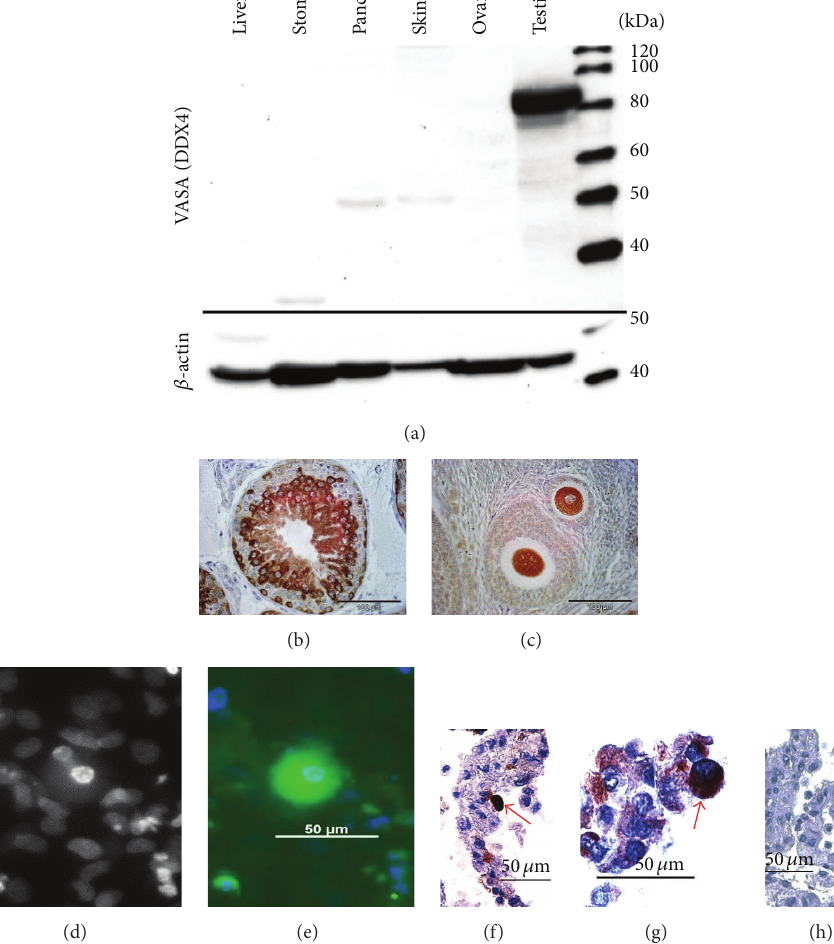
Figure 6: Characterization of the VASA antibody and detection of VASA-positive cells in OCCs. (a) Western blot analysis using marmoset monkey protein samples demonstrates the specificity of the VASA antibody. ∗ indicates that the ovary was from an aged animal. The ovarian germ cell pool was therefore most likely strongly reduced or even exhausted leading to undetectable VASA protein concentrations in the sample. (b and c) Immunohistochemical application of the VASA antibody to marmoset gonads showed germ-cell-specific labeling in the adult testis and the adult ovary. (d) DAPI staining of a part of an OCC. Note the intensely stained nucleus in the central part. (e) The same area shown in (d). The large cell containing the intensely stained nucleus strongly stains for VASA. The signal is blurry due to the fact that the picture was taken through the bottom of a normal cell culture dish. (f, g) Examples of isolated VASA-positive cells in sections of paraffin- embedded